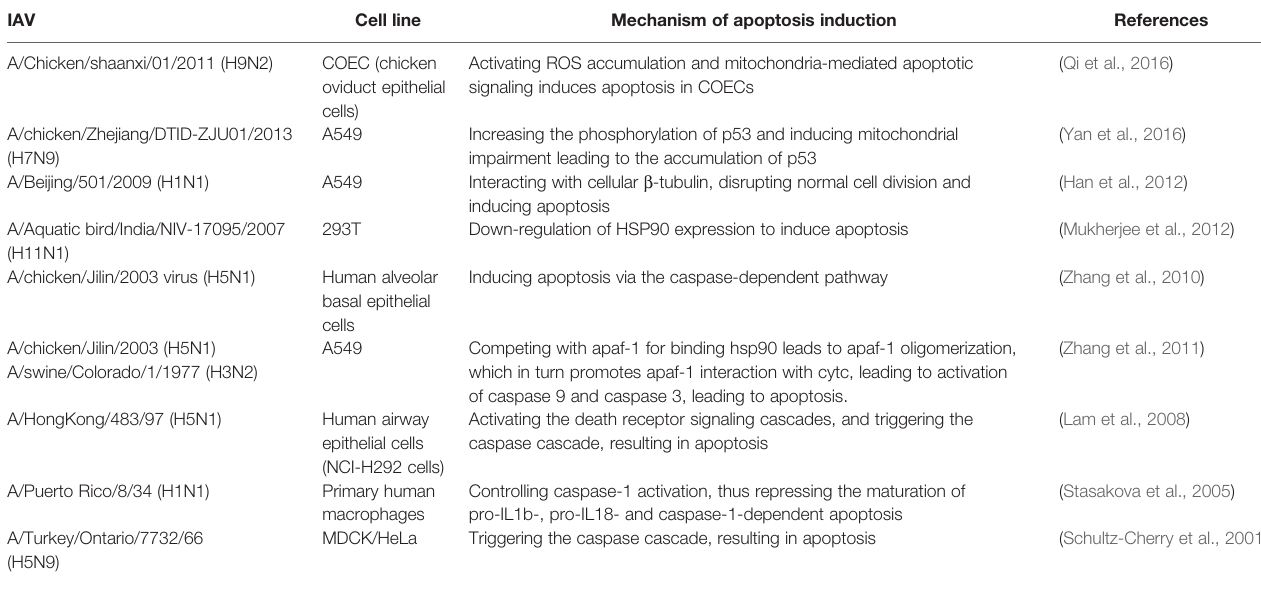
TABLE 2 | Different subtypes of IAV NS1 proteins induce apoptosis in various cell types. IAV Cell line Mechanism of apoptosis